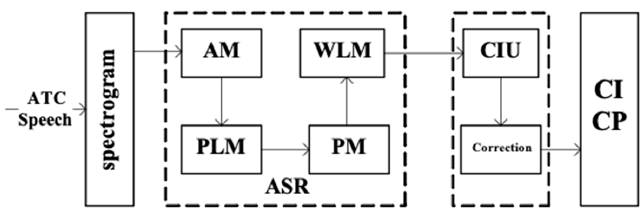
Figure 1. Structure of the proposed framework. ATC speech: the communication speech between air traffic controllers (ATCOs) and pilots; AM: acoustic model; PM: pronunciation model; PLM: phoneme-based language model; WLM: word-based language model; CIU: controlling instruction